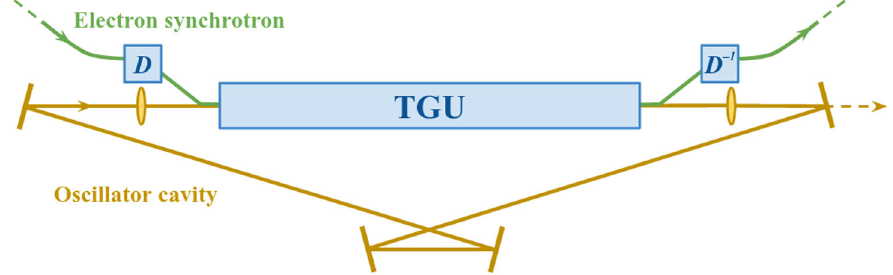
FIG. 2. Schematic of the TGU-XFELO driven by an electron synchrotron. The three constituent components are the electron synchrotron (green), the TGU mechanism (blue), and the optical cavity (orange). The TGU mechanism consists of the undulator itself, as well as dispersive sections denoted by D and D − 1